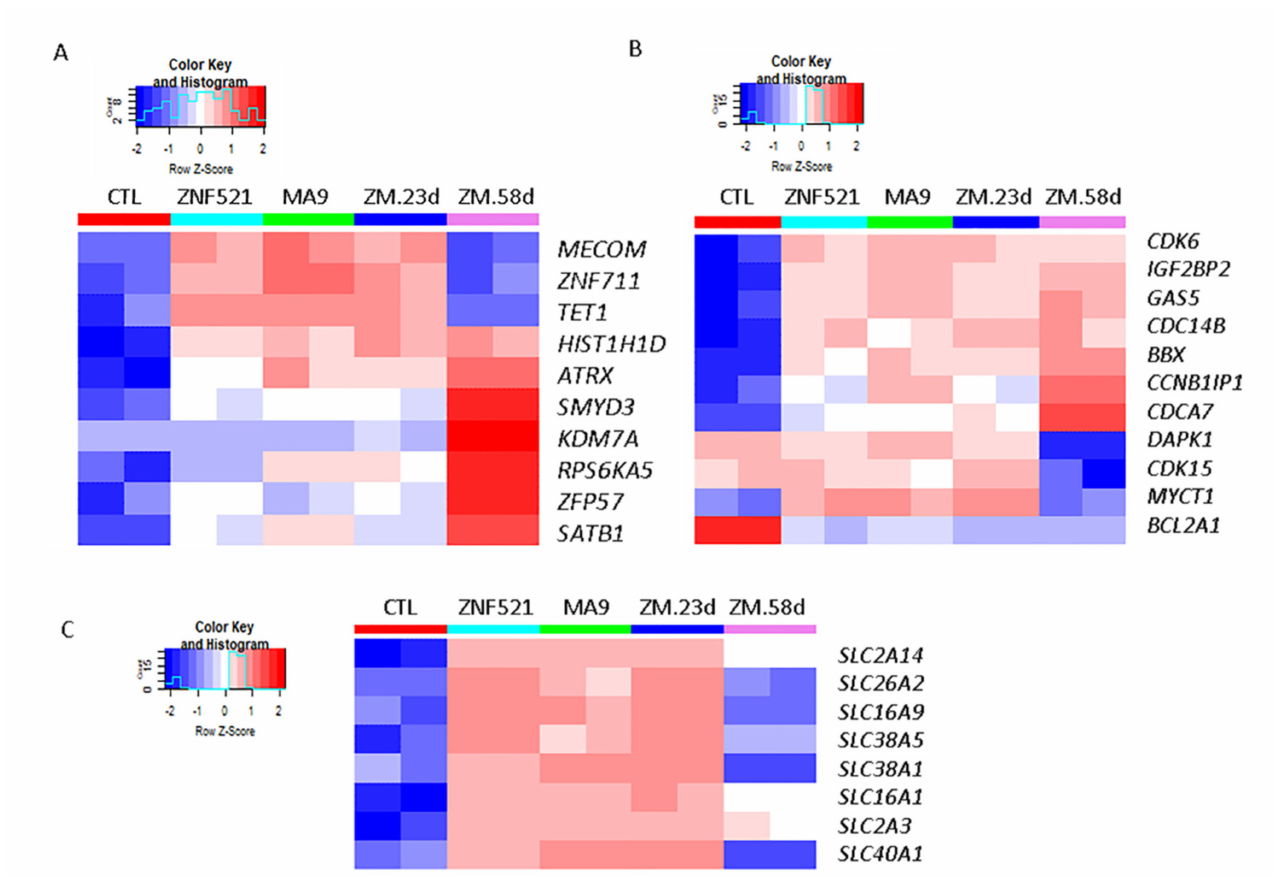
Figure 5. Heatmaps of selected differentially expressed transcripts in ZNF521, MA9, and ZNF521-MA9 (ZM) at 23 days and/or in ZNF521-MA9 (ZM) at 58 days compared to the control condition. ( A ) Genes involved in epigenetic functions. ( B ) Genes involved in cell cycle function. ( C ) Transporter genes. Blue–red color scale was used to set rows with a mean of zero and a standard deviation of